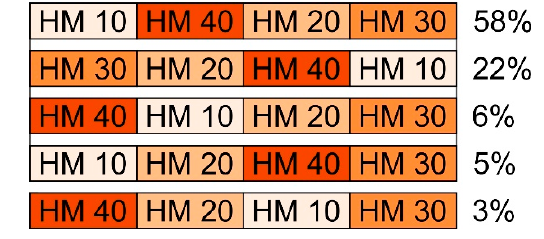
Figure 8. Most frequently indicated